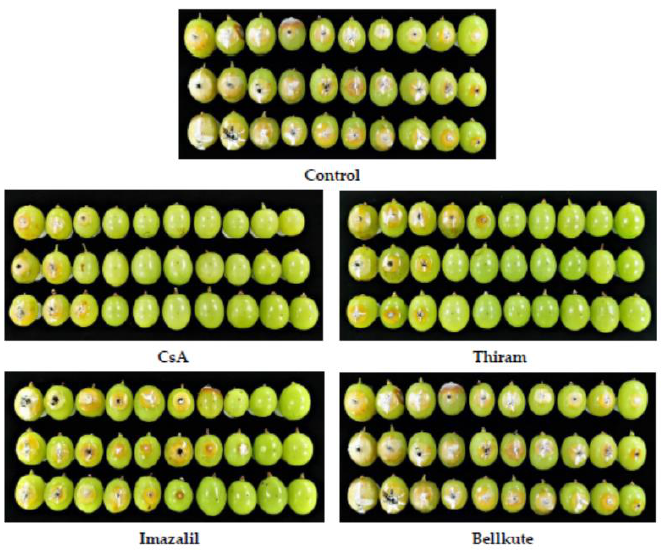
Figure 2. The disease control efficacy of control (0.1% ethanol), cyclosporin A (CsA), thiram, imazalil, and bellkute with concentration at 50 mg/L against A. niger on grapes.